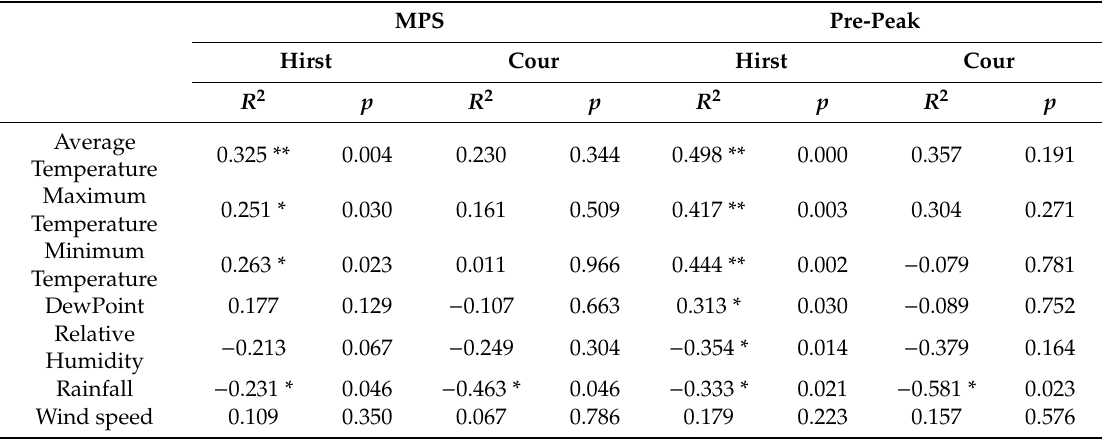
Table 3. Spearman correlation between Hirst and Cour pollen traps and main meteorological variables, during the main pollen season (MPS) and during pre-peak (** p ≤ 0.01; * p ≤ 0.05).